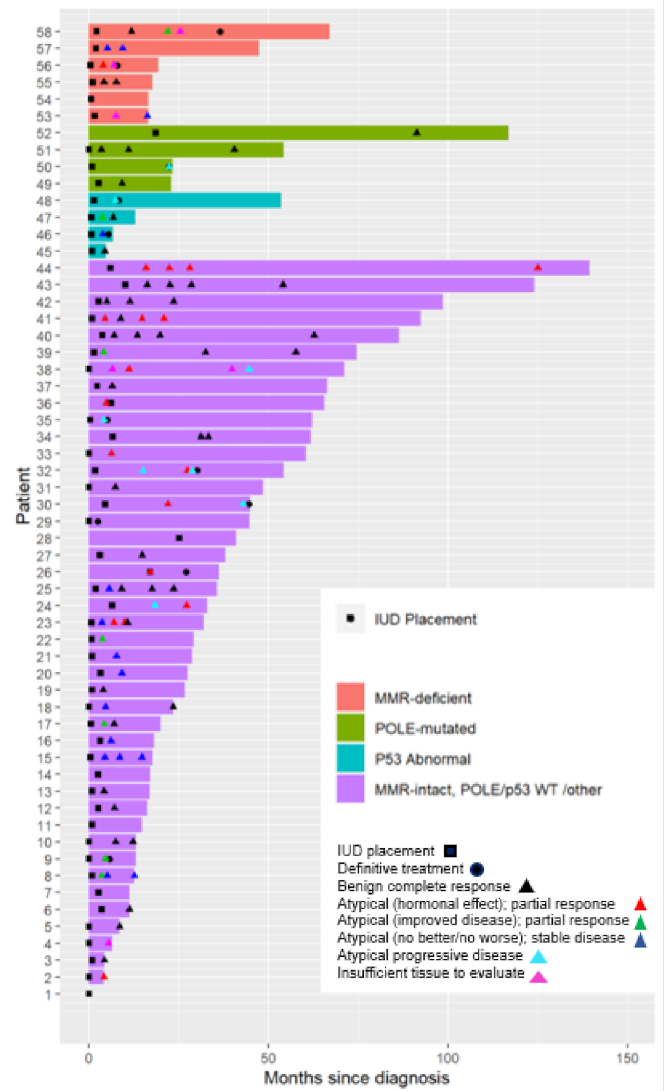
Figure 3. Swimmer plot demonstrating subjects’ ( n = 58) treatment duration, the time point of diagnosis, LNG-IUS placement, repeat biopsies, and definitive treatment. Abbreviations: MMR: mismatch repair; WT: wild type; IUD: intrauterine